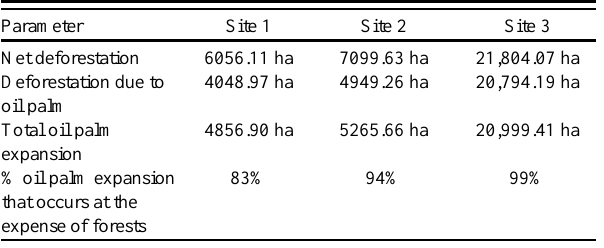
Table 7 . Deforestation and oil palm expansion in all sites.